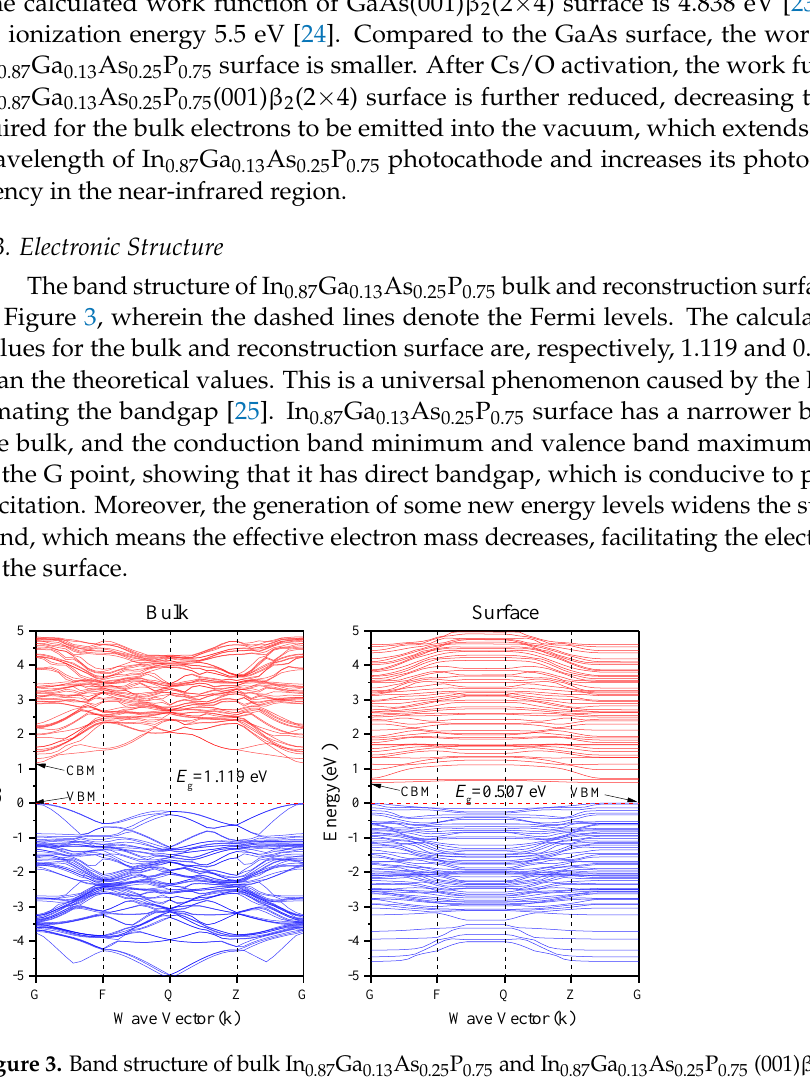
Figure 4. ( a ) Total DOS of the In 0.87 Ga 0.13 As 0.25 P 0.75 bulk and surface, ( b – e ) the partial DOS of the In, Ga, As and P atom in every layer. After reconstruction, the integral partial DOS of the surface considerably changes relative to the bulk. The variation is shown in Table 1, in which the symbols “+” and “–”